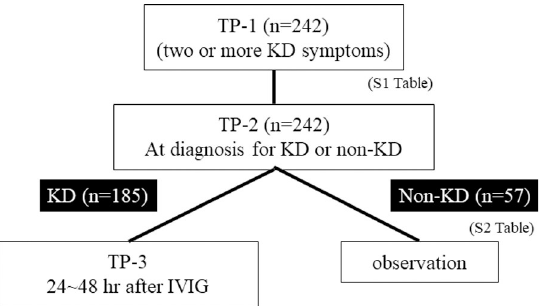
Fig 1. Flow chart of the study. TP-1: when a patient with two or more KD symptoms was suspected as having KD; TP-2: when a patient was diagnosed as KD or non-KD by a provider; and TP-3: 24–48 hours after first IVIG in a patient with